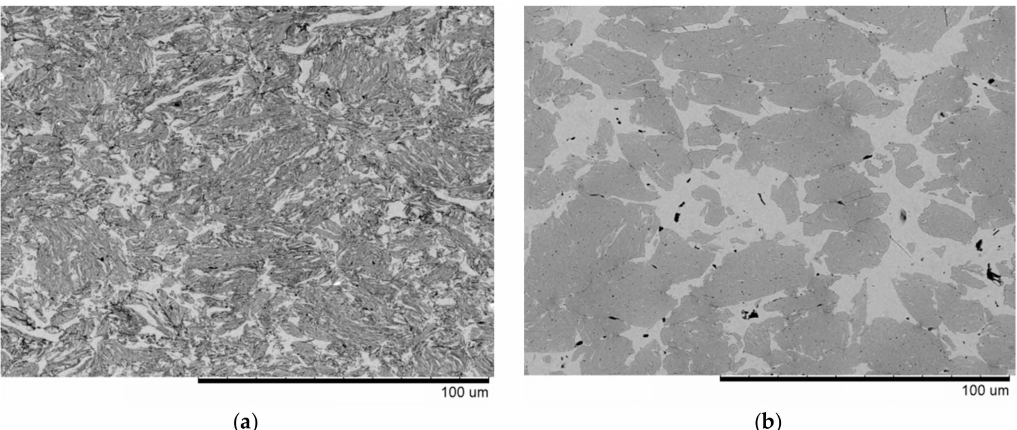
Figure 4. Microstructure of TiC–Cu composites obtained by Spark Plasma Sintering (SPS) of ( a ) the ball-milled mixture of Ti 25 Cu 75 and carbon black, ( b ) the ball-milled mixture of Ti 25 Cu 75 and nanodiamonds, from which un-milled pieces of ribbons were separated. The images were taken in the back-scattered electron mode.